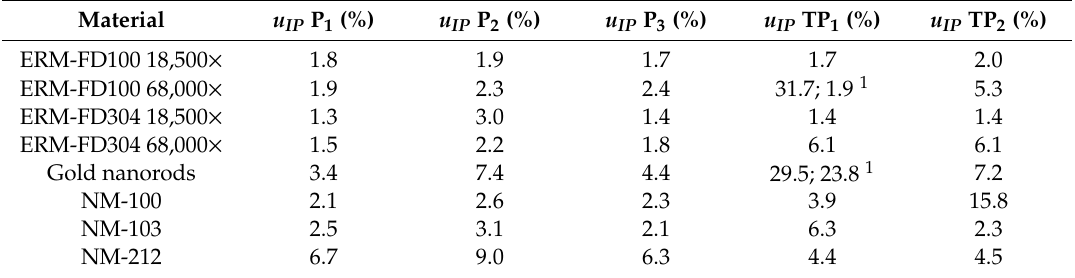
Table 4. u IP obtained for the measurement of the median of the minimal Feret diameter of the di ff erent materials by experienced trained labs referred to as partner 1 (P 1 ), partner 2 (P 2 ), and partner 3 (P 3 ), and by two independent test persons (TP 1 and TP 2 ).